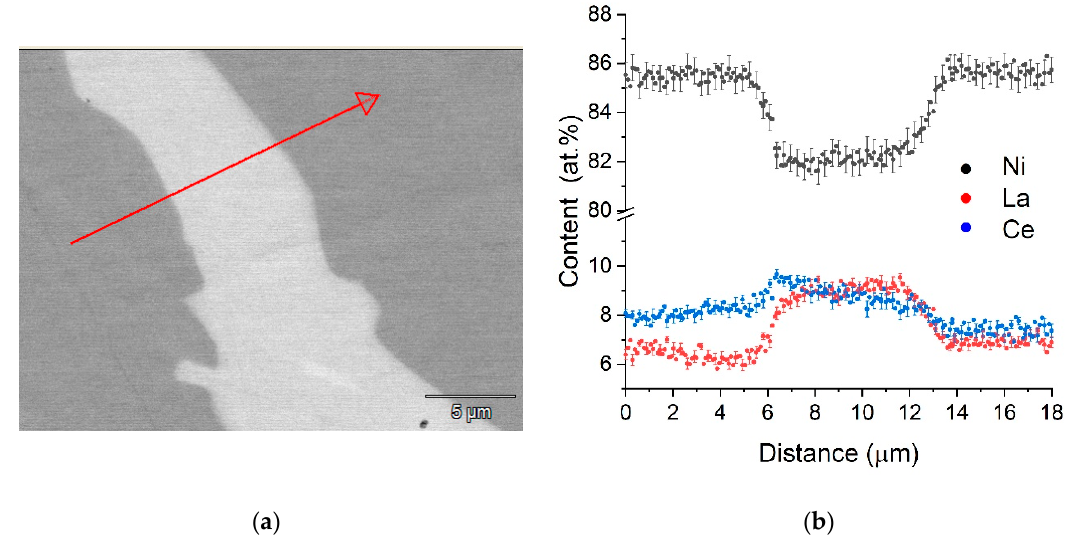
Figure 6. Chemical composition line scan for the La 0.5 Ce 0.5 Ni 5 sample: (a) BSE image of the investigated area and (b) chemical composition as a function of distance along the marked line.